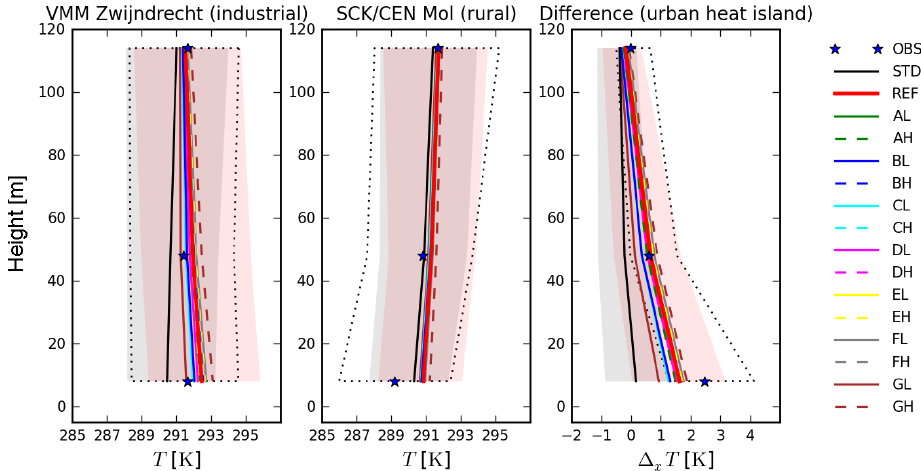
Figure 5. Observed (stars) and modelled (lines) nocturnal (0h) vertical profiles for VMM industrial site in Zwijndrecht and the SCK • CEN rural site in Mol, averaged for the summer period of 21 July to 20 August 2012. STD (black) indicates the simulation with standard model COSMO-CLM without urban parametrization. REF uses the same setup as STD, but showing results of TERRA_URB v2.0 coupled to COSMO-CLM. An overview of the remaining simulations (AL, AH, BL, BH, etc.) can be found in Table 2. The dotted lines indicate the range between the 16 and 84th percentile of the observed profiles, whereas the grey and light red areas indicate the ranges for the simulations STD and REF,